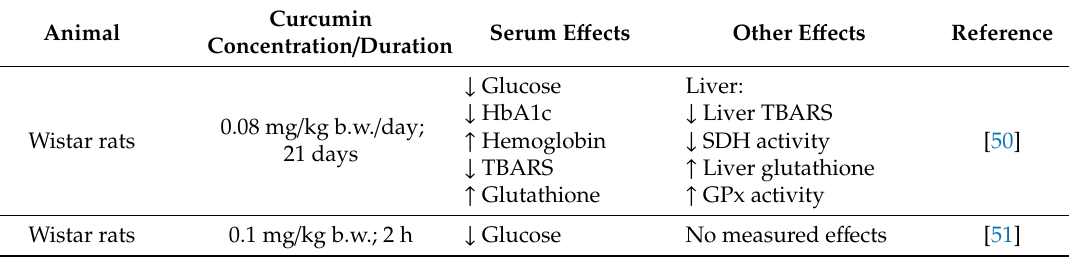
Table 2. Evidence of antidiabetic e ff ects of curcumin: in vivo alloxan-induced diabetes animal studies.